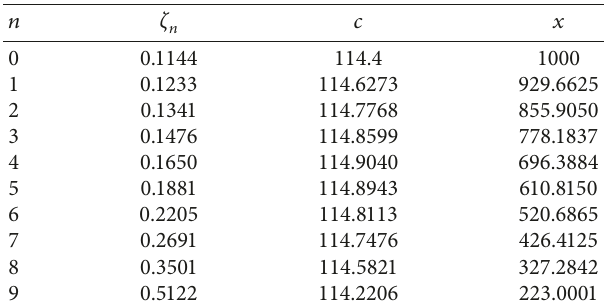
Table 4: Evolution of optimal consumptions and wealth